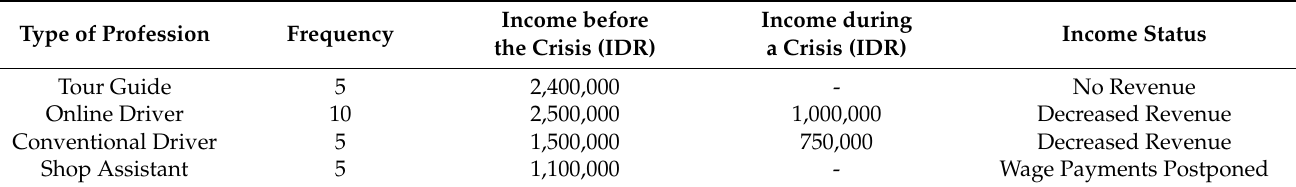
Table 2. The informant’s income before and during the COVID-19 pandemic, and income status. Type of Profession